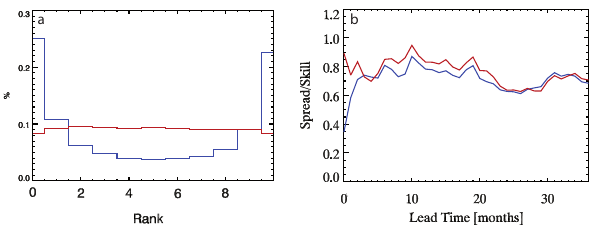
Fig. 3. Globally averaged upper ocean temperature (0–700m): (a) Fig.3. Globallyaveragedupperoceantemperature(0-700m):(a)Talagranddiagramforthelagged(blue) Talagrand diagram for the lagged (blue) and bred (red) initialized and bred (red) initialized ensemble for a lead time of one month. (b) Spread-error ratio for the lagged (blue) and bred initialized ensemble (red). ensemble for a lead time of one month. (b) Spread–error ratio for the lagged (blue) and bred initialized ensemble (red).